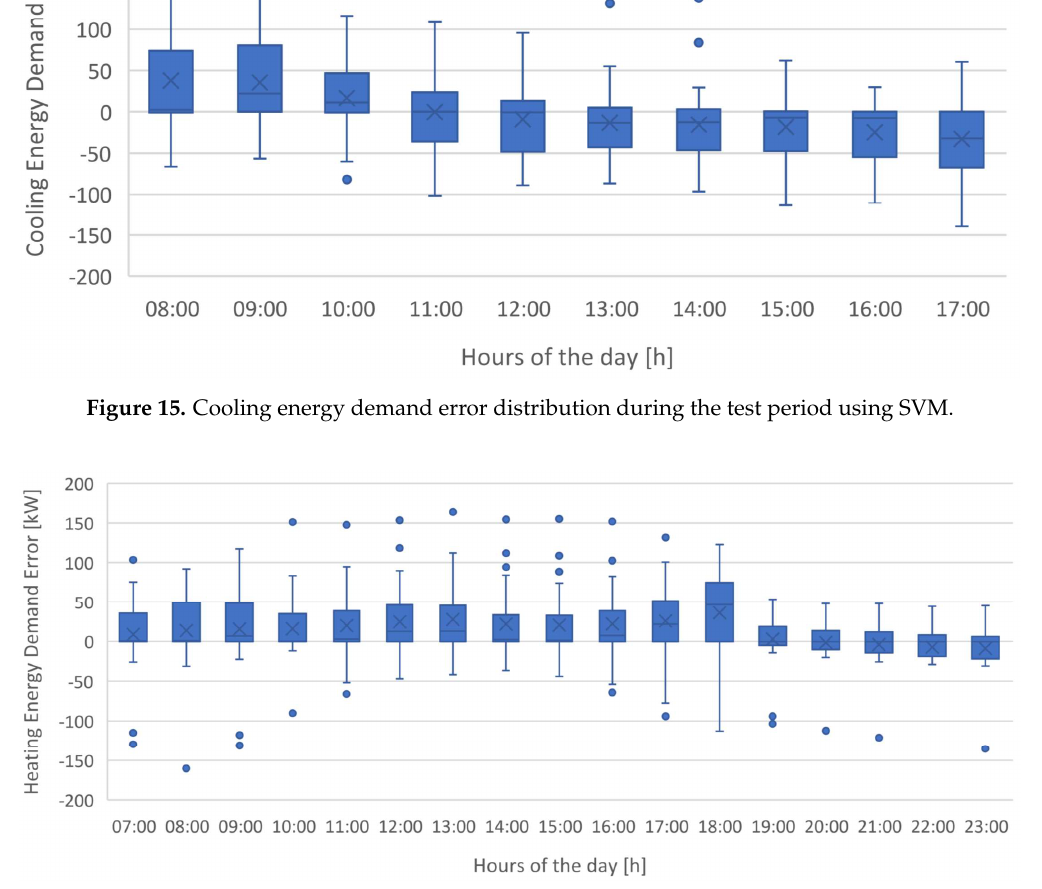
Figure 16. Heating energy demand error distribution during the test period using an SVM